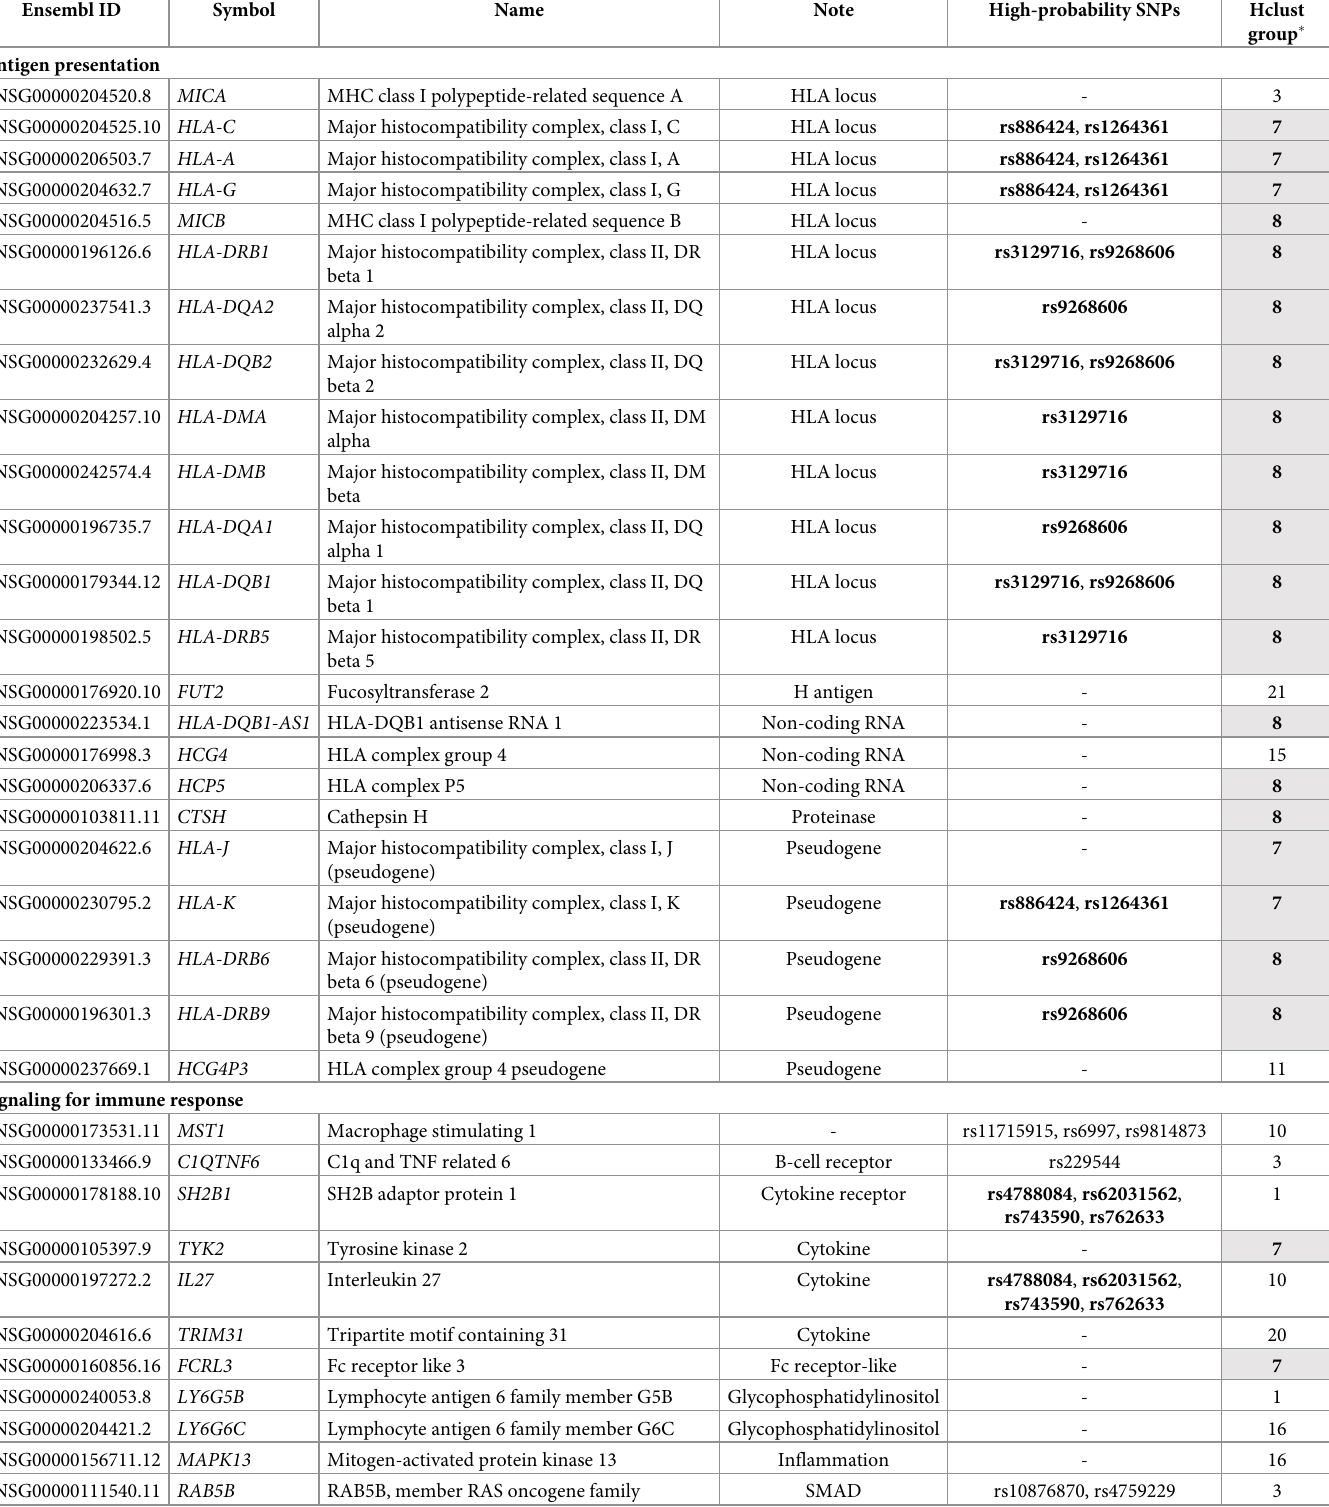
Table 2. Genes involved in immune response represent the largest functional category of eQTL-associated genes. Ensembl